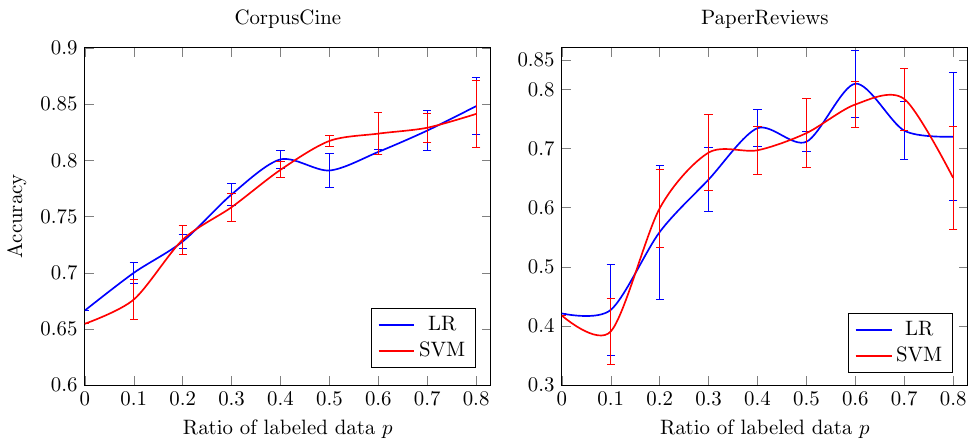
Figure 2. Accuracy of our approach (LR and SVM) as a function of the number of labeled data.